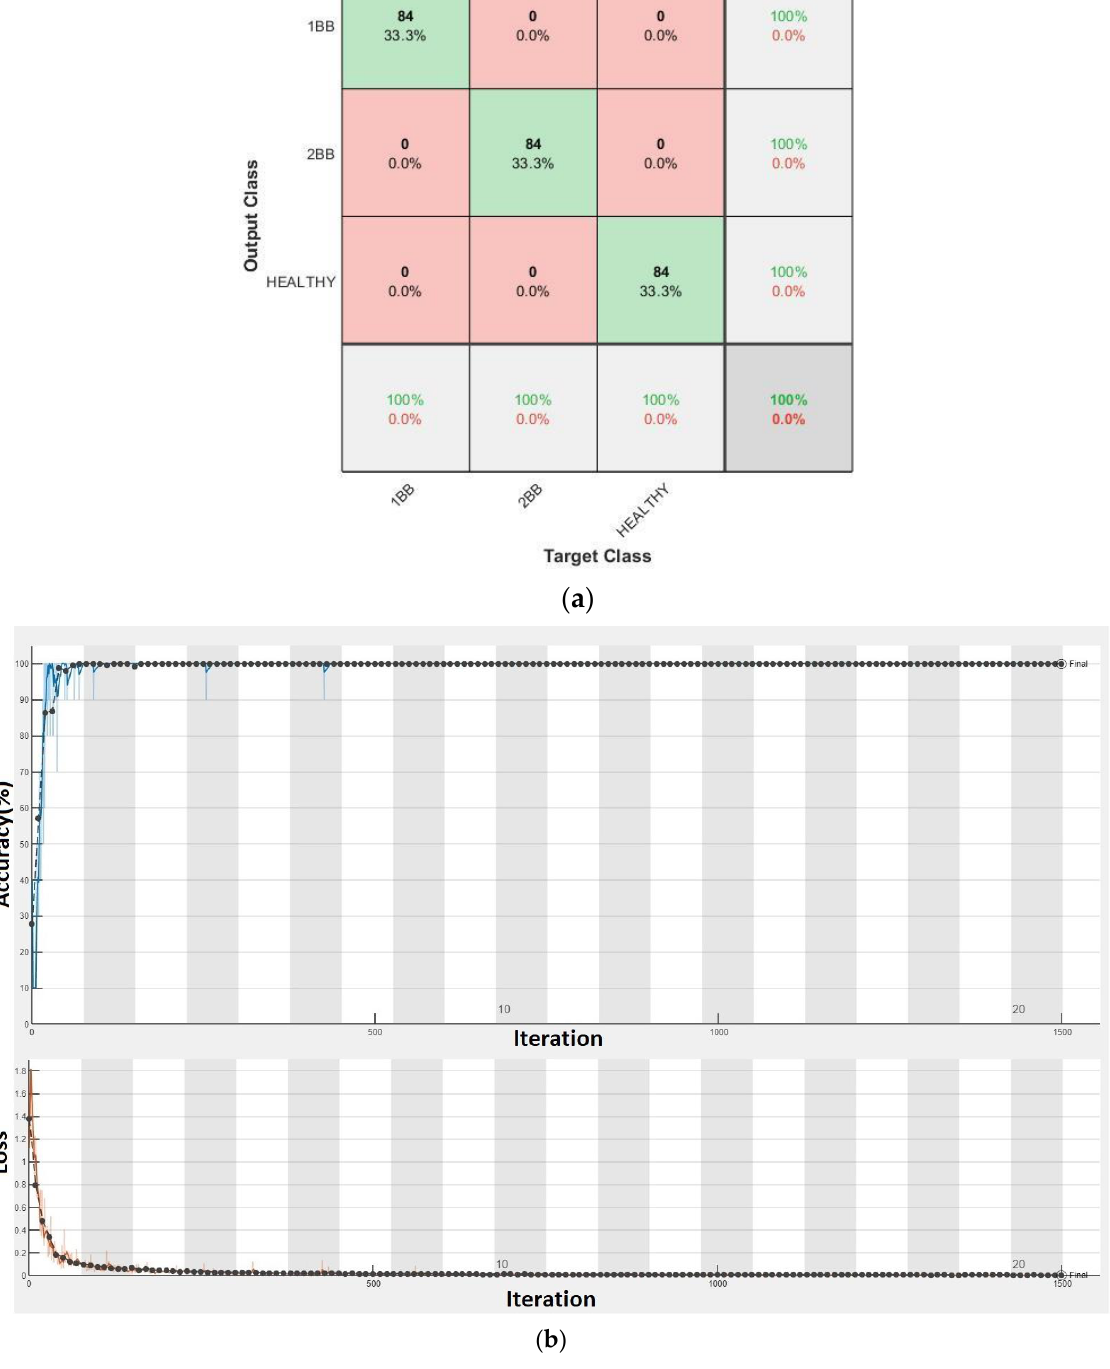
Figure 17. Results for Siemens soft starter: ( a ) Confusion matrix. ( b ) Training progress. For the case of the OMRON model, 567 training samples (189 samples per category) were used to train the CNN and 189 (63 samples per category) different samples were used for the validation. In Figure 18, it can be observed that the accuracy of the CNN also in this case reaches 100%. Furthermore, the training process reaches 100% accuracy after about 160 iterations, in epoch three. Moreover, it becomes stable at 100% after, more or less, 340 iterations.